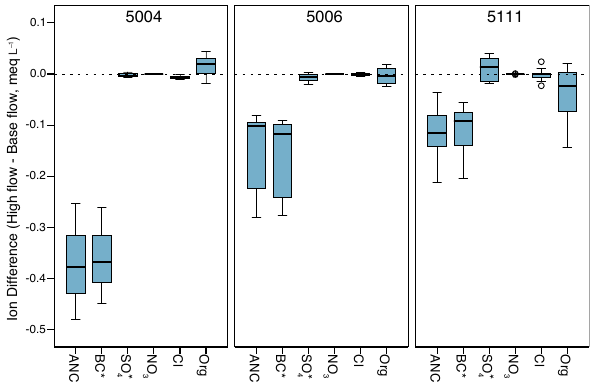
Fig. 6. Loss of acid neutralizing capacity (ANC) and concurrent changes in major ions and organic anions (Org) in unlimed streams at high flow compared to base flow (high flow minus base flow, i.e. negative numbers indicate dilution and positive numbers indicate enrichment at high